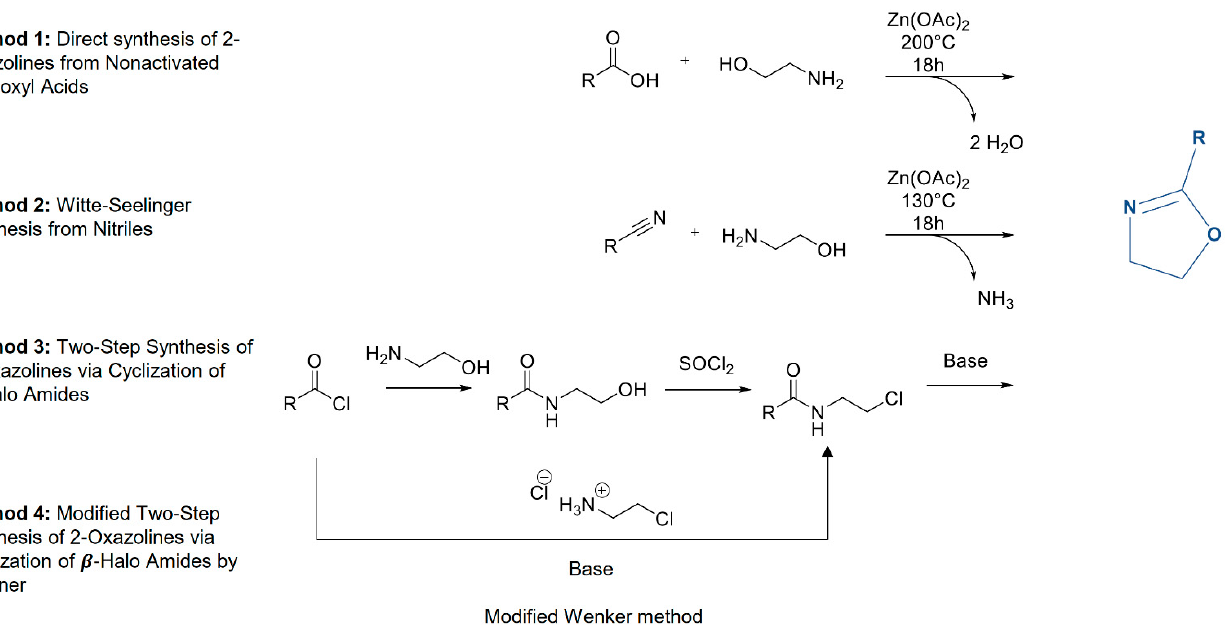
Figure 3. The representation of possible routes for 2-oxazoline monomer synthesis. Adapted from [19].